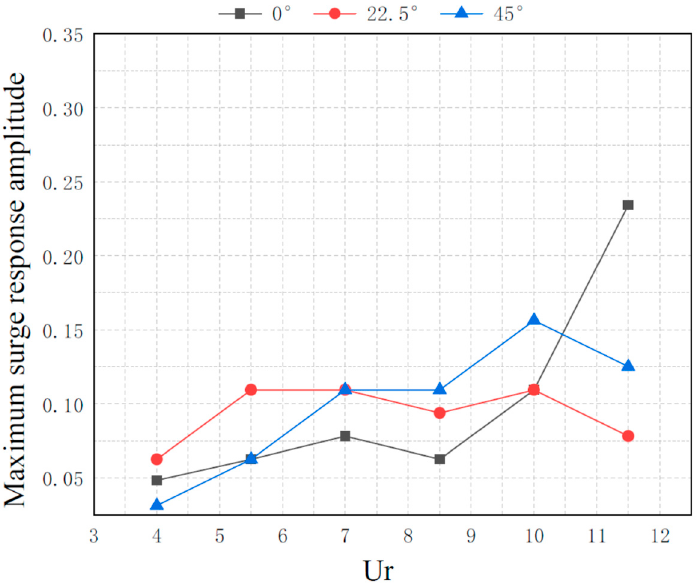
Figure 4. Maximum response amplitude of floating body surge under three flow angles.